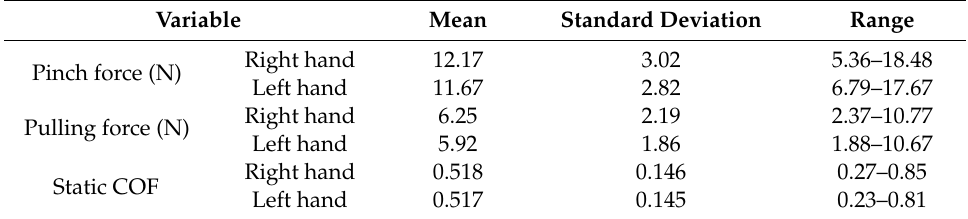
Figure 13. Distribution of: ( a ) pinch force; ( b ) pulling force; and ( c ) static COF for 50 volunteers. Table 2. Summary of pinch force, pulling force, and static COF values at slip onset for 50 volunteers.